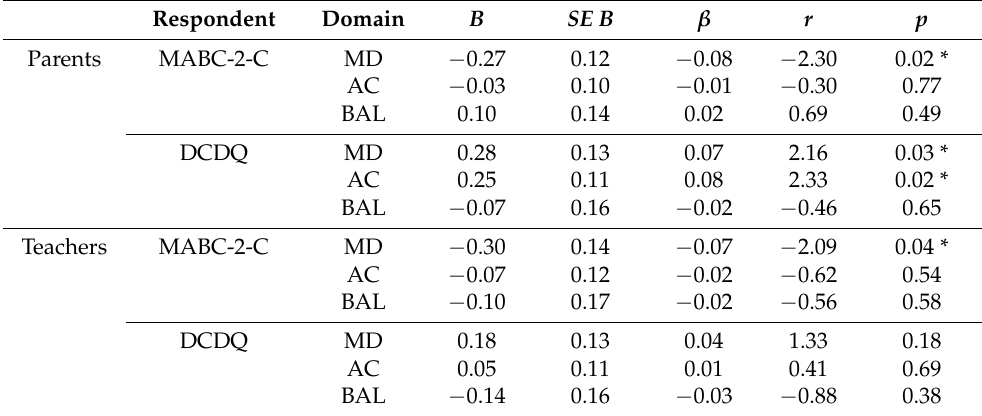
Table 10. The linear regression models of how the scores of parents and teachers’ MABC-2-C and DCDQ reflect three different motor domains as assessed by the Movement ABC-2 Test children without suspected DCD ( n =